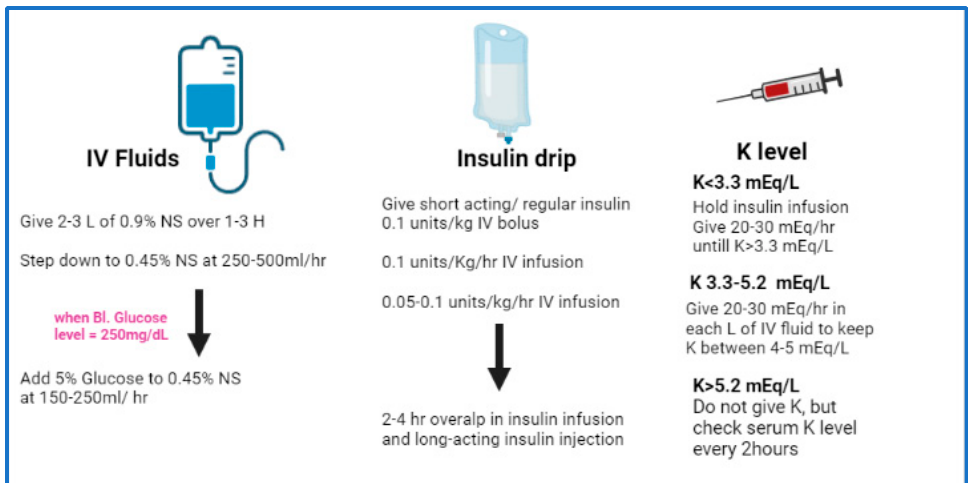
Figure 2. Schematic representation of a simplified protocol/workflow for management of adult patients with DKA . Abbreviations: NS, normal saline, H, hour, Bl. blood, K potassium, IV intravenous.